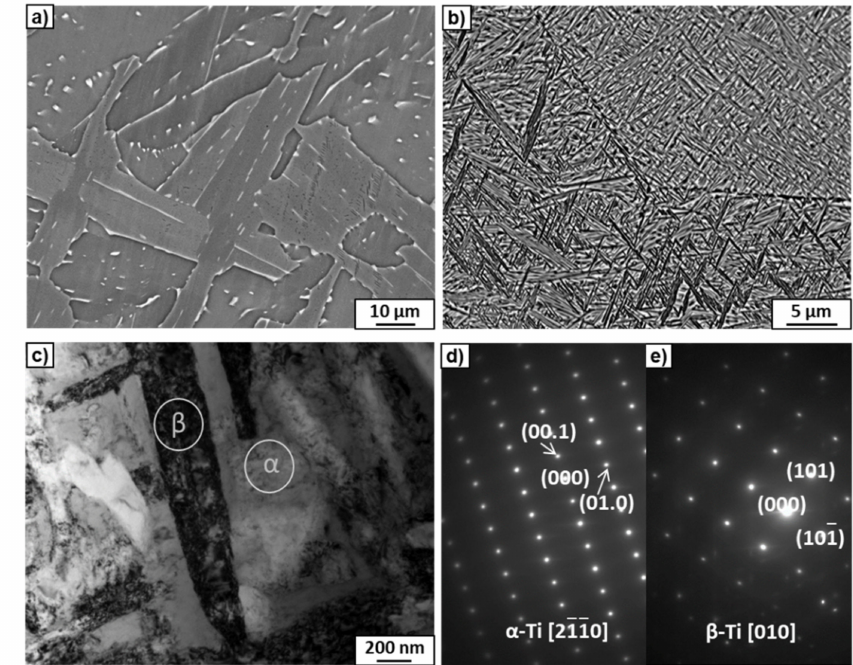
Figure 2. SEM micrographs of the Ti–3wt.% Nb ( a ) and Ti–20wt.% Nb ( b ) alloys annealed at 600 and 520 ◦ C, respectively. TEM bright-field image of Ti–20wt.% Nb ( c ) and the SAED patterns ( d , e ) acquired from the areas marked by white circles at the places where α - and β -phases existed, respectively.